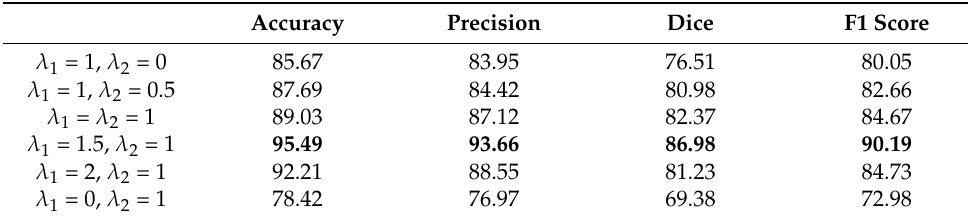
Table 6. Comparison of models under different